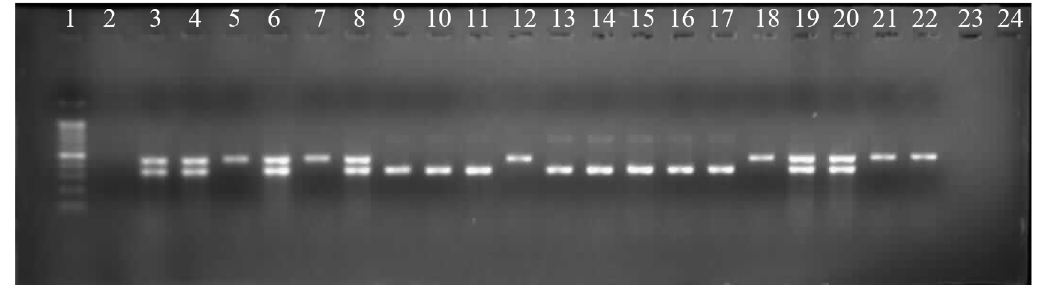
Fig. 1. PCR products of 21 serovars. (1): ladder 100bp; (2): negative control; (3): positive control; (4 - 24): serovars in which S. Indiana (pork) and S. Agona (fish) were the wells of 23 and 24 without any